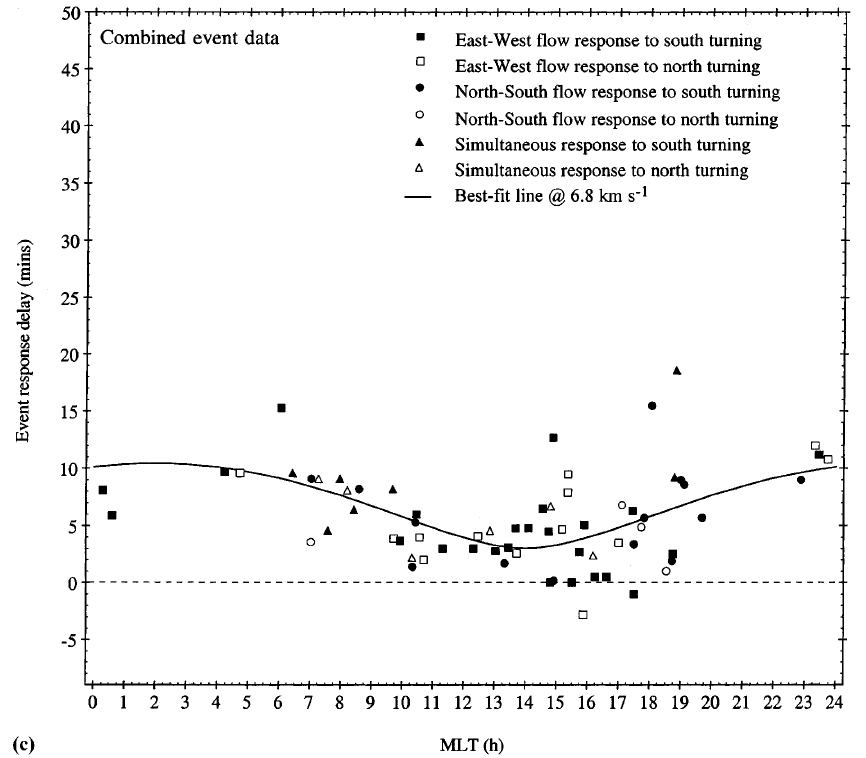
Fig. 7. c As for a , except that the mini- mum delay is shown for each event, irrespective of which flow component is involved. Closed symbols indicate respons- es to southward turns of the IMF, while open symbols indicate responses to north- ward turns of the IMF. Responses ob- served first in the east-west flow component are shown by squares , while those observed first in the north-south component are shown by circles . If both components responded simultaneously the symbol is plotted as a triangle . These data have been least-squares fit to the same simple theoretical model as in Fig. 5c, shown by the solid line . In this case the best-fit epicentre of information propaga- tion was also found to lie at 1400 MLT, while the expansion phase speed was found to be 6.8 km s )